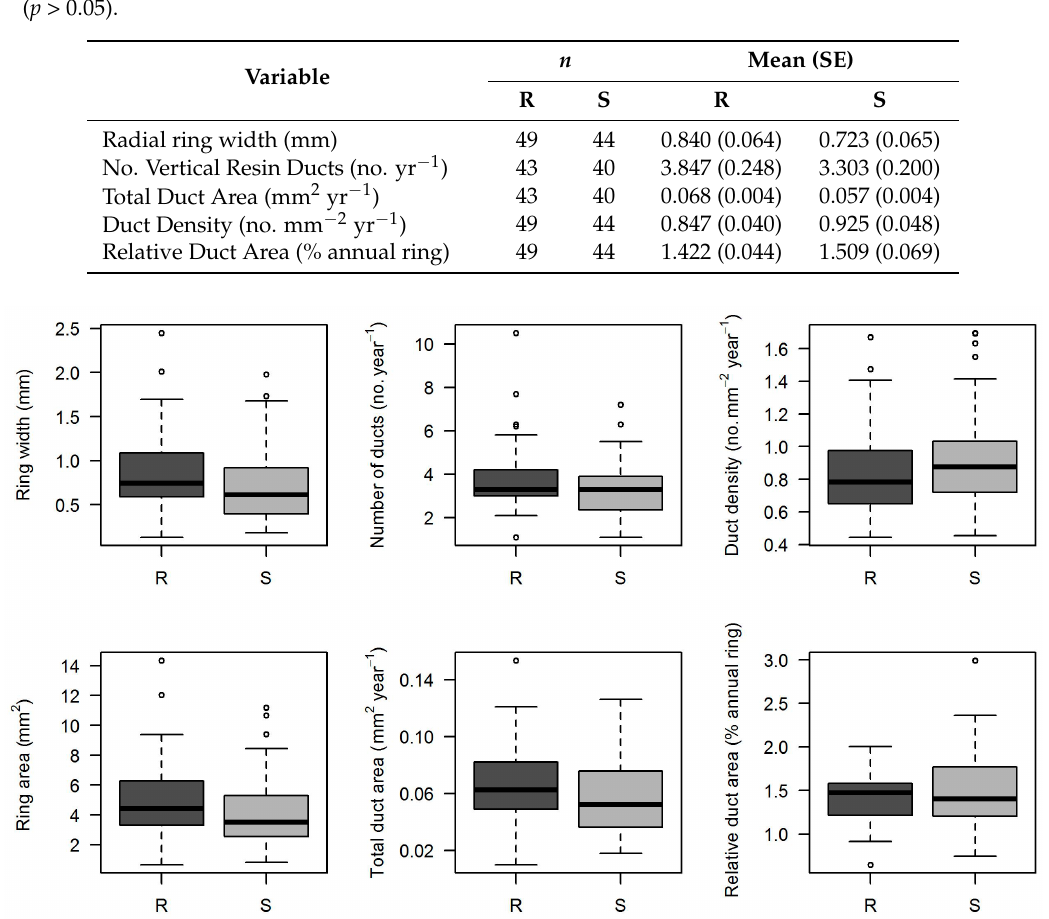
Figure 2. Limber pine vertical resin duct metrics averaged per year from the 10-year interval 2001 to 2010 for R and S trees. All metrics were calculated using the extracted cores, not the entire tree stem. Boxes show medians and 1st and 3rd quartiles, and whiskers indicate 1.5 inter-quartile range of untransformed data.